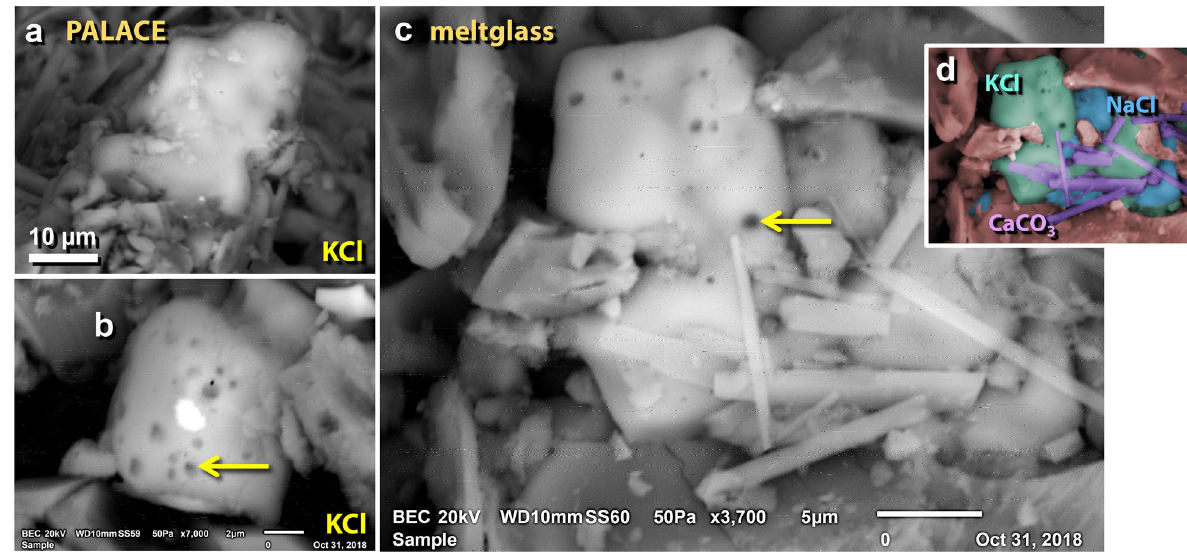
Figure 47. SEM images of melted potassium and sodium salt grains. ( a) , ( b ) Potassium chloride (KCl) grains melted into the surface of the palace mudbrick meltglass. ( c ) Melted NaCl and KCl grains. Bubbles at arrows suggest the salt grains exceeded their melting points. ( d ) Manually constructed EDS-based phase map of panel ‘ c ’, showing potassium chloride (KCl; green), sodium chloride (NaCl; blue), and spindle-like calcium carbonate crystals (CaCO 3 ;